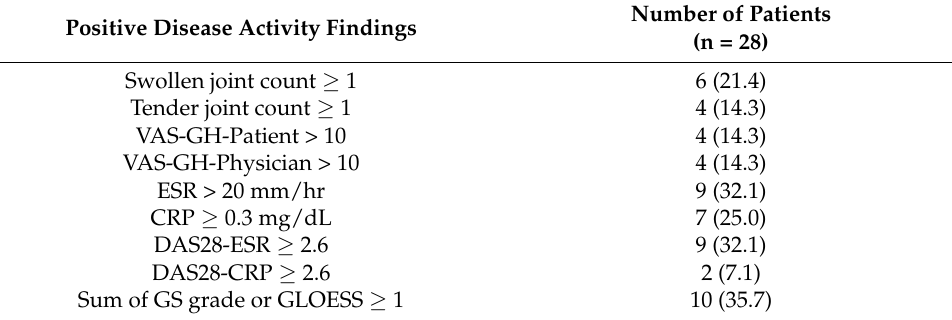
Table 5. Patients with positive disease activity findings at the PDUS remission status a